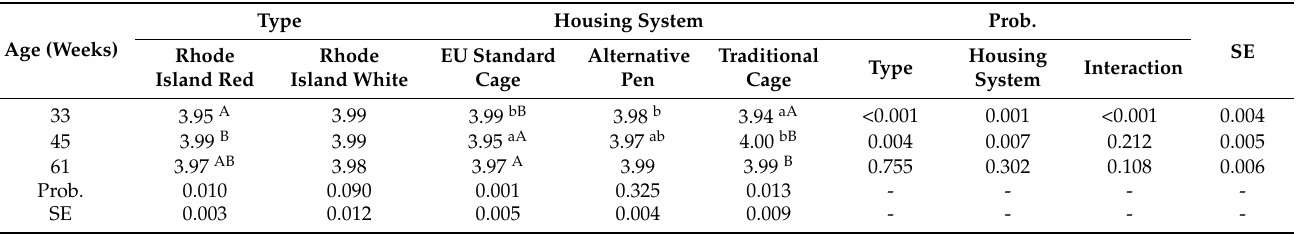
Table 6. Effect of type and housing system on the plumage points on the breast feathers of non-beak- trimmed Rhode Island hens.